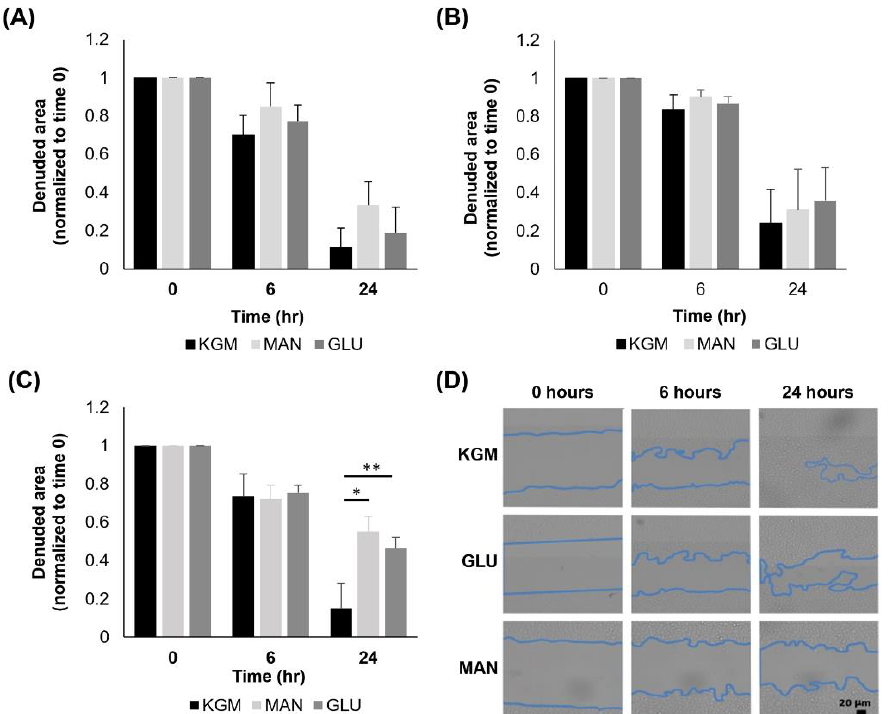
Figure 8. Cell migration was impeded by hyperosmotic stress. ( A ) There was no measurable difference in the rate of cell migration in cells exposed to hyperosmolar or hyperglycemic stress for 24 h ( p = 0.179 at 6 h, p = 0.154 at 24 h). ( B ) There were no differences in migration after 7 days of culture in high glucose or mannitol ( p = 0.0343 at 6 h, p = 0.905 at 24 h). ( C ) Prolonged (14 days) hyperosmolar stress-impaired cell migration at 24 h ( p = 0.197 at 6 h, * p < 0.001 and ** p = 0.02 at 24 h). ( D ) Phase contrast imaging showing cell migration over 24 h. Scale bar: 20 mm. Data are presented as mean ± standard deviation. Graphs are representative of one experiment that was repeated three independent times. One-way ANOVA, SNK multiple comparison test.